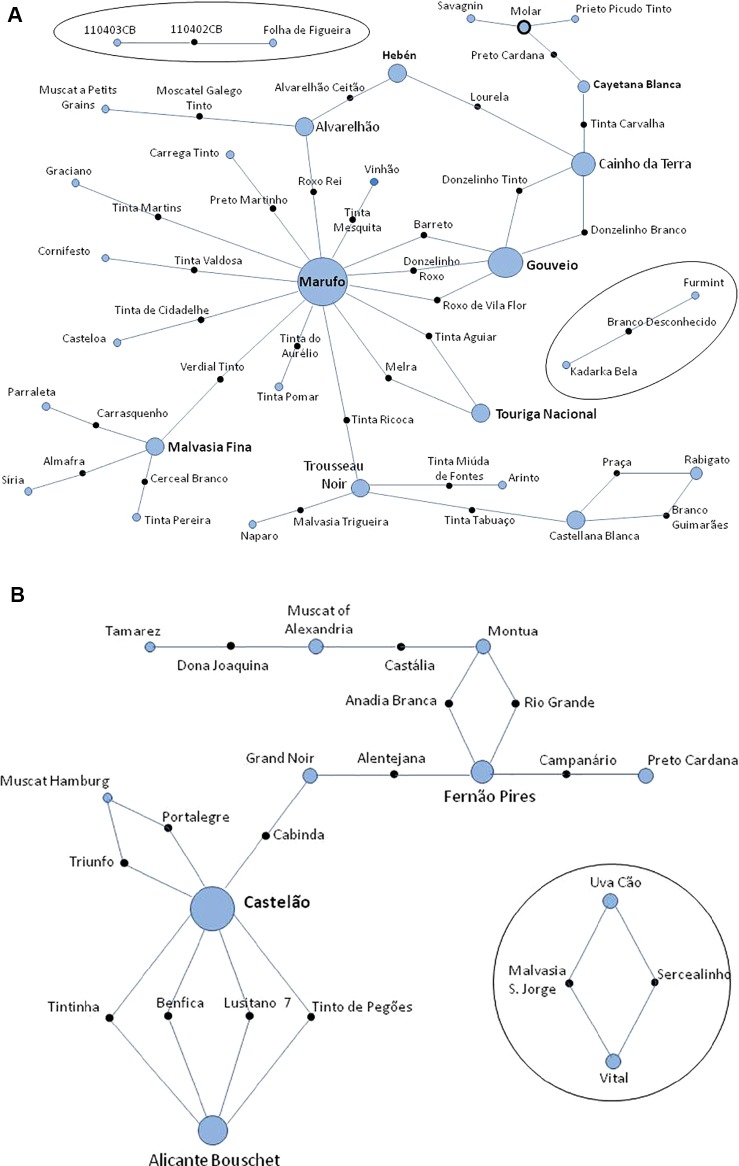
Networks of the proposed trios (parents and offspring) found in a parentage analysis of Portuguese set of Vitis vinifera germplasm using 261 single nucleotide polymorphism (SNP) markers. (A) Thirty-two previously unknown genetic relationships of varieties and/or wild plants; (B) confirmation of 15 pedigrees of new varieties reported by Almeida breeder in 1950. Solid black circles represent the offspring; blue circles represent the progenitors; circle diameter is proportional to the number of relationships where is involved; blue circles surrounded by a solid black line represent a variety that is an offspring and parent in the figure. The tree is not drawn to scale.